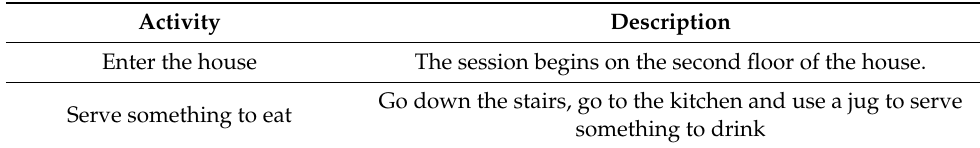
Table 1. Activities carried out by participants during data